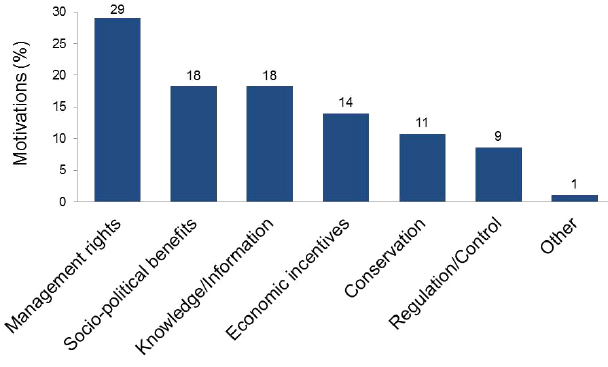
Fig. 3 . Motivations to participate in participatory environmental monitoring projects (n = 36 papers that stated